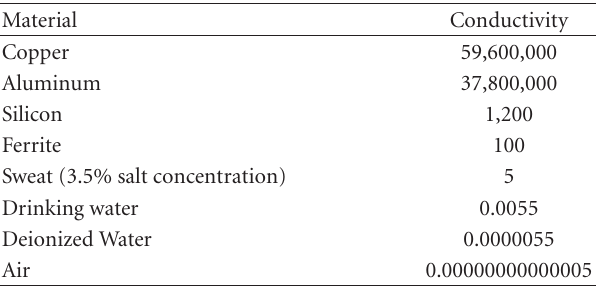
Table 3: Specific conductivity of sweat and other common sub- stances (source: